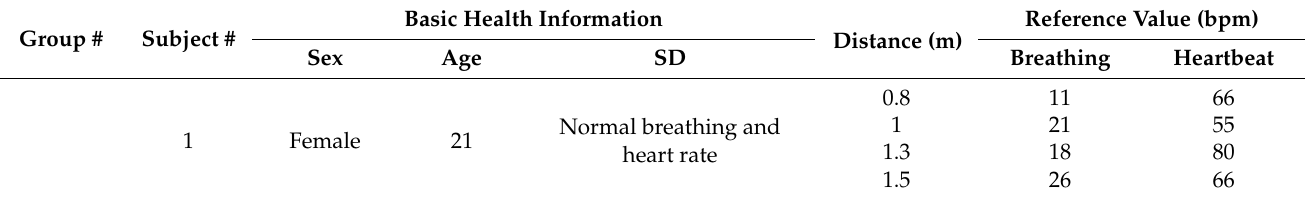
Table 2. Subjects’ basic